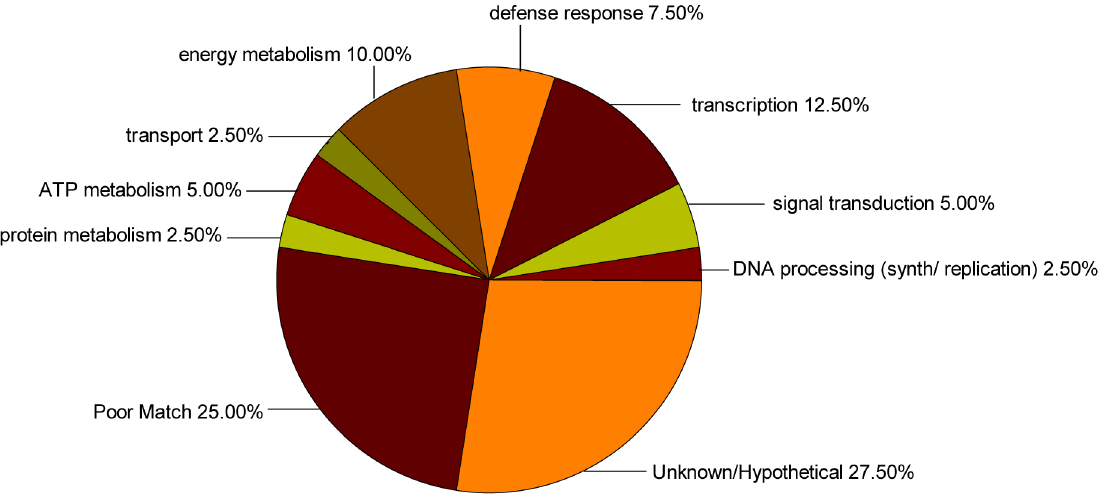
Figure 2. Functional classification of unigenes from the forward SSH library within biological process category.